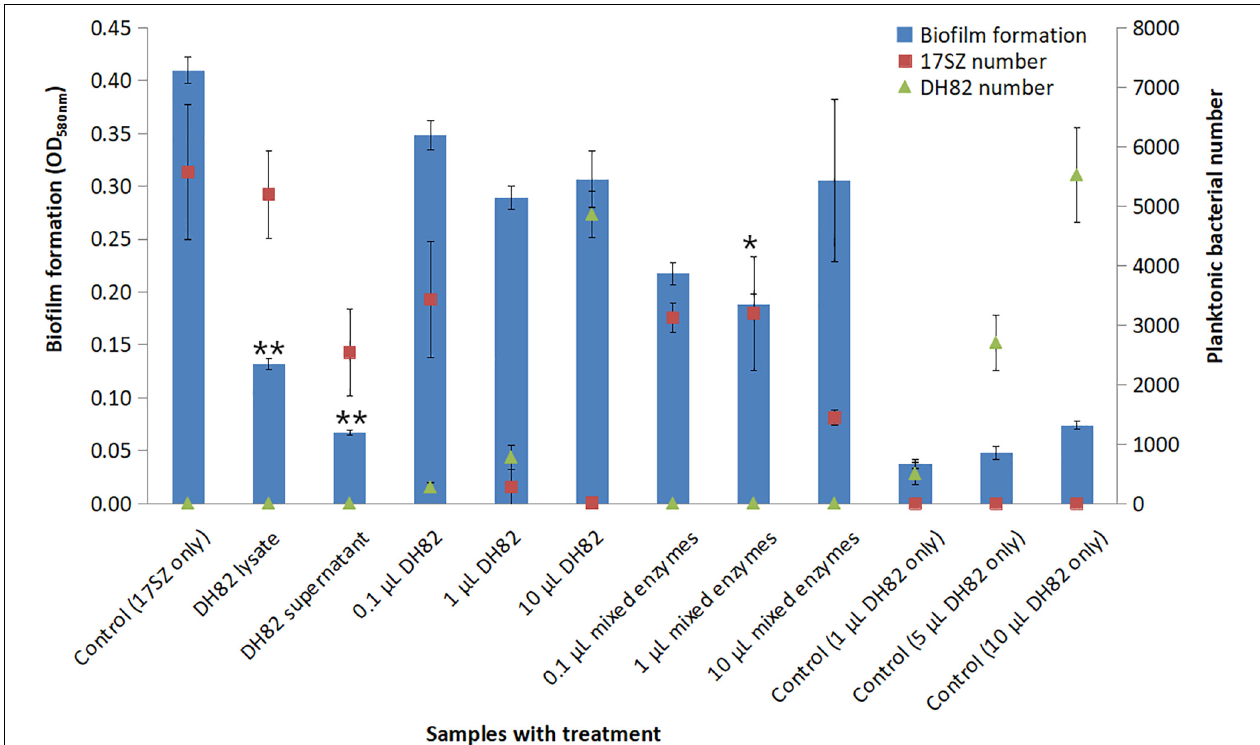
FIGURE 2 | Effect of fractions of DH82 on the biofilm and planktonic bacterial amount of Vibrio parahaemolyticus. Each 100 µ L of DH82 supernatant and lysate, 0.1, 1, and 10 µ L DH82 overnight culture (10 7 CFU/mL), 0.1, 1, and 10 µ L QQ enzyme (AiiA and YtnP mixture) were respectively mixed with 1 µ L of 17SZ overnight culture (OD 600 nm 0.1, 10 8 CFU/mL) in 200 BM medium, compared with 17SZ with PBS as a negative control, the mixtures were incubated in 30 ◦ C for 3 days. The biofilms were analyzed by crystal violet assay, and the supernatants of biofilm cultures were spread on Luria–Bertani (LB) agar plates to calculate the planktonic bacterial number. The biofilms are presented by blue bars, the number of planktonic bacteria of 17SZ is presented (cid:4) in red, the DH82 by (cid:78) in green. The error bars are presented as the standard deviation. The error bars are presented as the standard deviation. Statistical analysis results are presented by the significant difference indicated by * where p < 0.05 and ** where p <